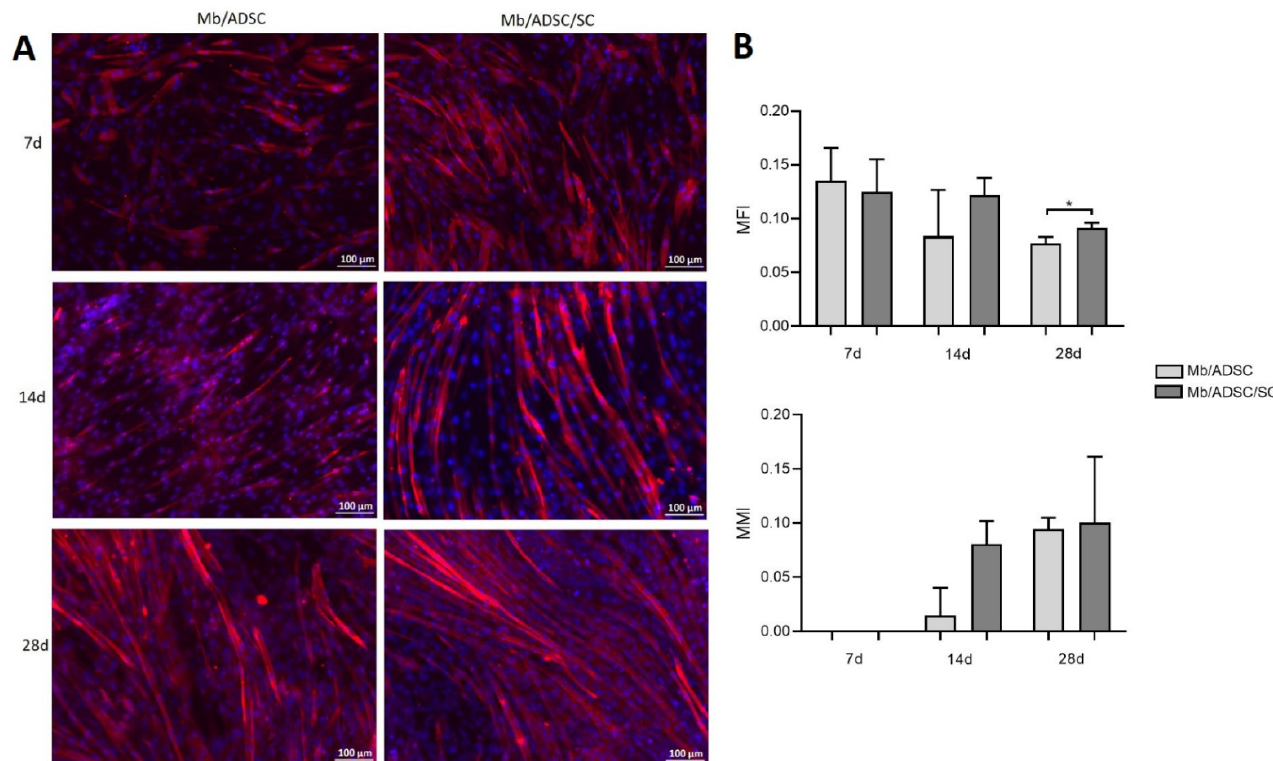
Figure 5. Myotube formation after 2D myogenic differentiation of Mb/ADSC vs. Mb/ADSC/SC. Values are presented in mean ± standard deviation. ( A ) Fluorescence microscopy of 2D co-cultures shows myosine heavy chain (MHC) positive (red) multinucleated (DAPI = blue) cells after 7, 14, and 28 days of myogenic differentiation. Scale bar 100 µm. ( B ) Myotube fusion index (MFI = nuclei in myotubes/total nuclei) was higher in Mb/ADSC/SC after 28 days (* p < 0.05, unpaired t -test). Myotube maturation index (MMI = myotubes with five or more nuclei/total myotubes) did not differ between Mb/ADSC and Mb/ADSC/SC during all time periods.